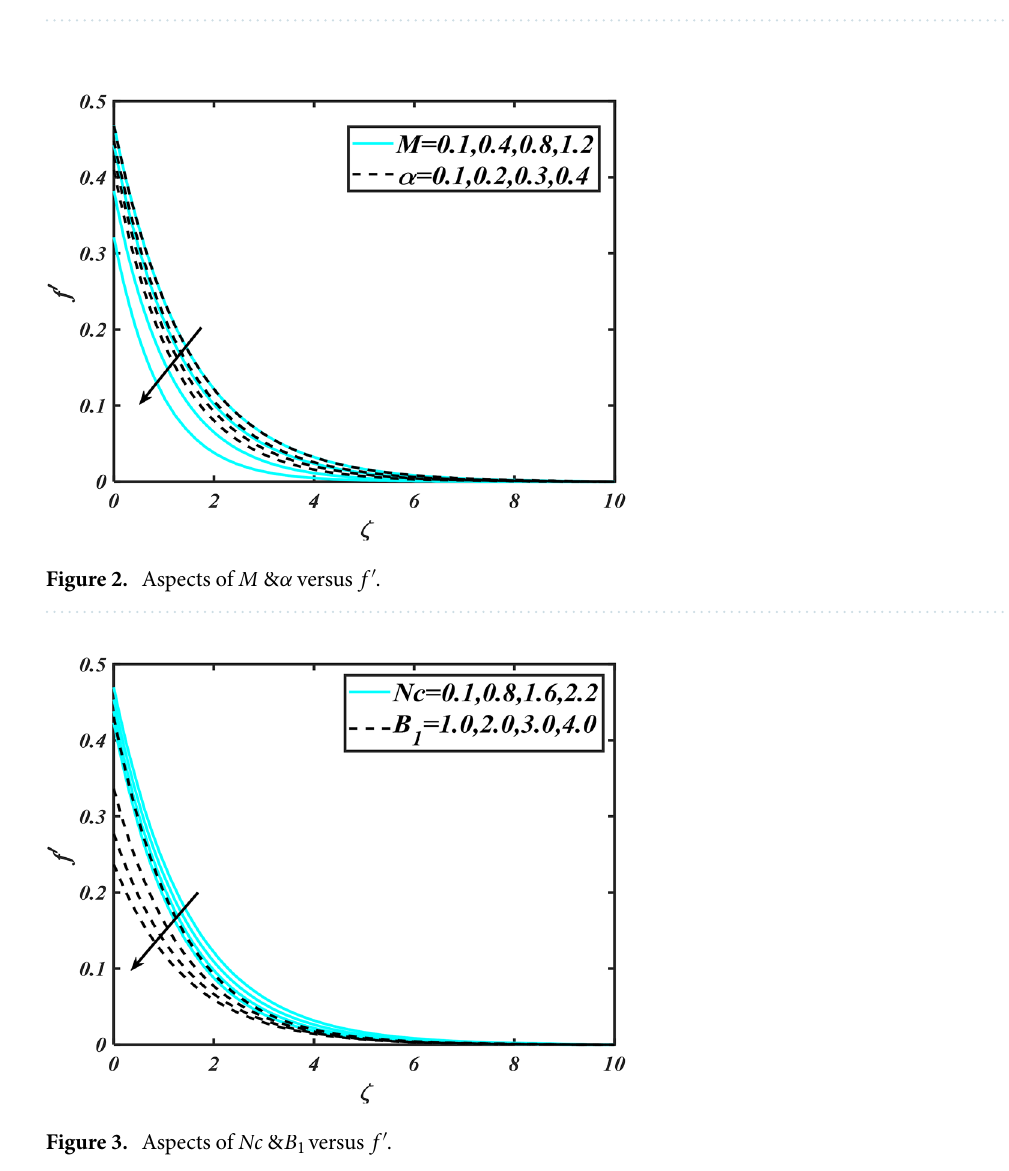
Table 5. Validation of current result with the previous result when ( Nr = 0 , (cid:31) = 0 , Bi = 0 , Nc = 0 , E = 0 , Lb = 0 , and Pe = 0 ).